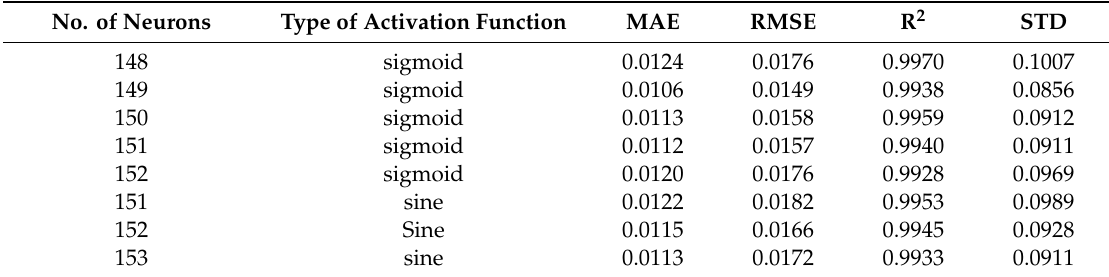
Table 5. Performance of Extreme Learning Machine (ELM)